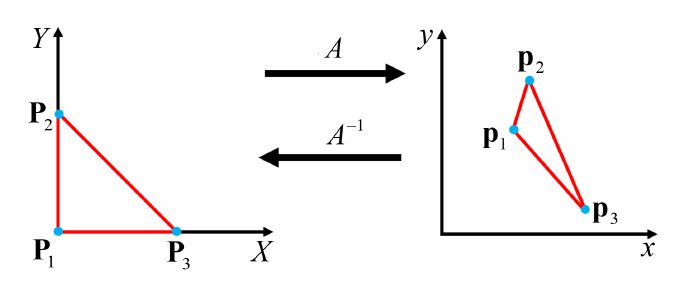
Figure 8. Affine Transformation from Unit Triangle to Desired